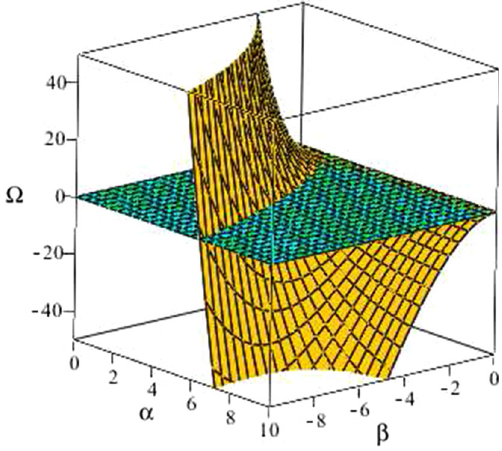
Fig. 11 The three dimensional plot of (cid:12) as a function of α and β for k = − 1